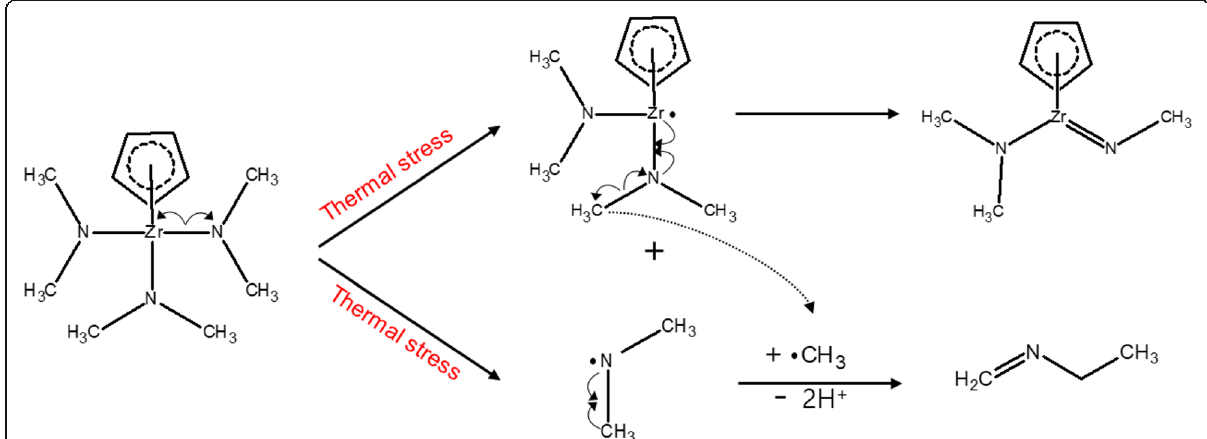
Fig. 5 The expected main decomposition mechanisms of CpZr(NMe 2 ) 3 on gas